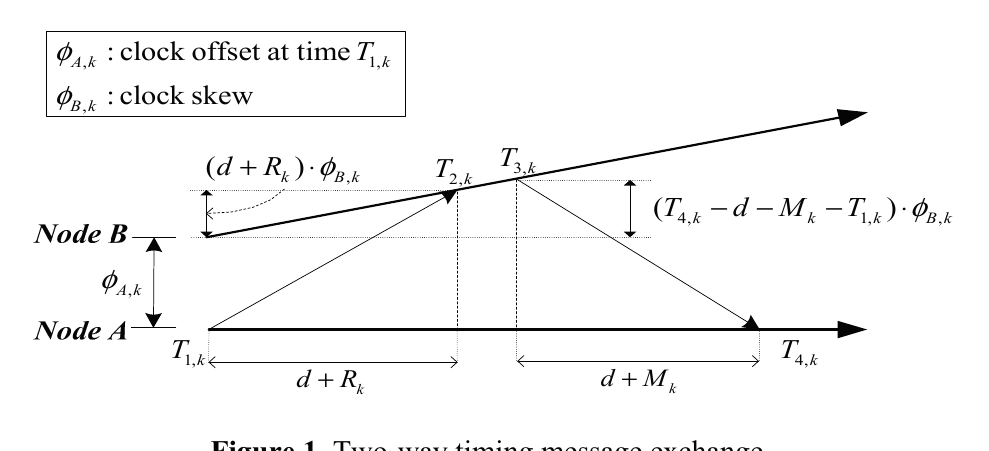
Figure 1. Two-way timing message